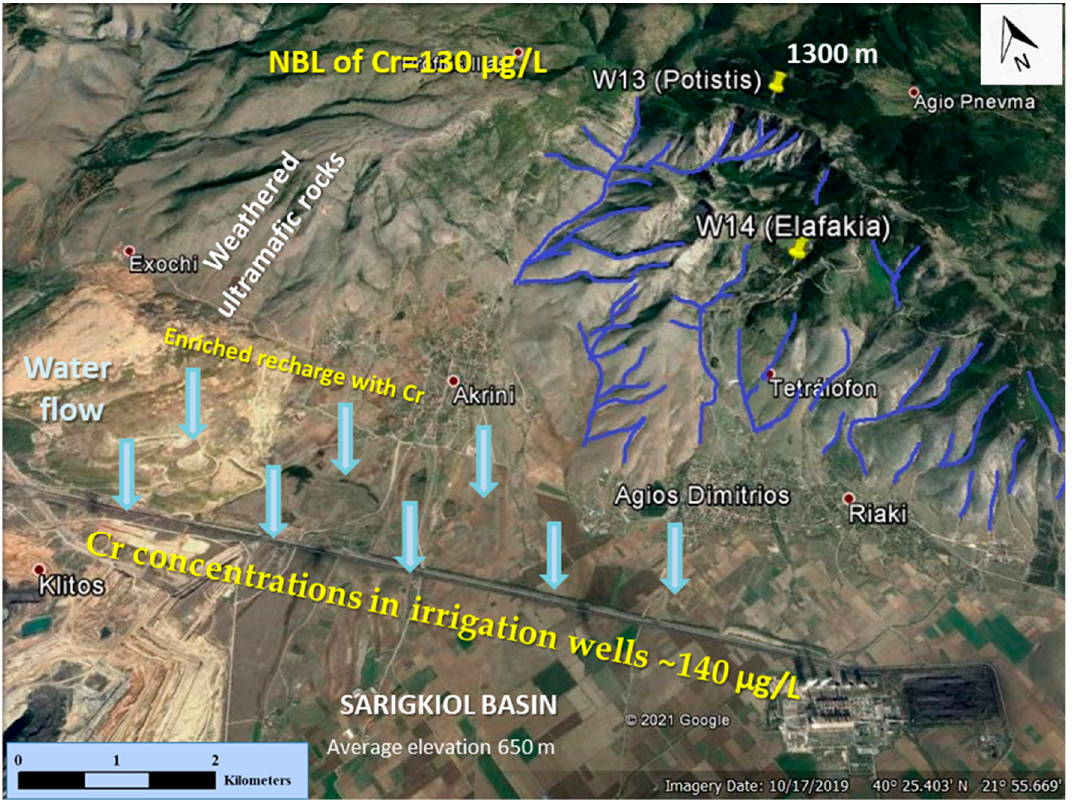
Figure 23. The flow paths and the natural recharge from western Vermio Mt. towards the eastern part of the Sarigkiol Basin (Google Earth image, 2021).